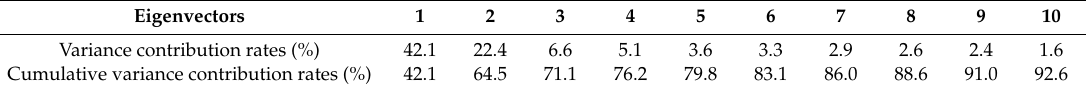
Table 1. Variance and cumulative variance contribution rates of the first 10